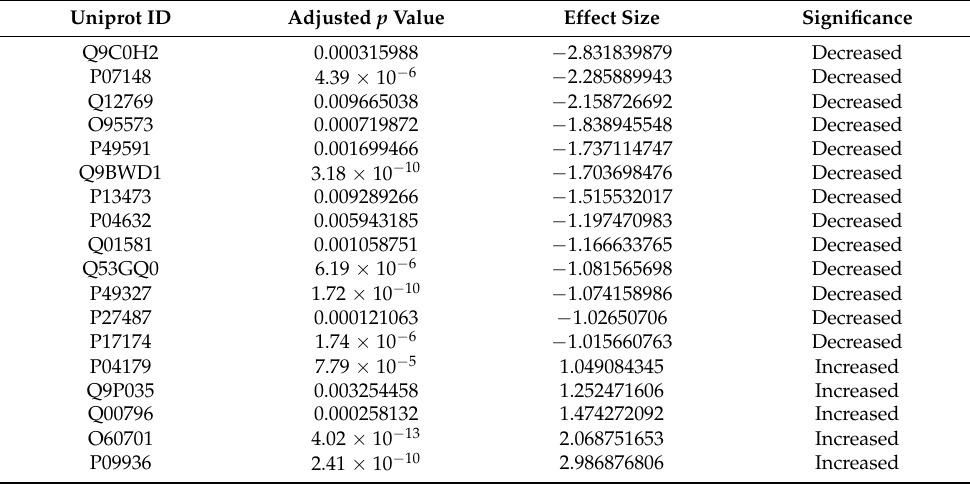
Figure 5. ( A ) Hierarchical cluster analysis and heatmap of differentially abundant proteins in resistant and parental phenotypes of Hep3B cells. Heatmap showing the abundance levels and clustering of the significantly differentially deregulated proteins (two-sample t -test with adjusted p value < 0.05; log2FC < 1; resistant/parental Hep3B cells). High protein intensities are colored red while low intensities are colored blue. Row headings represent protein names and column headings represent samples. Euclidean distance measure and Ward linkage analysis were used to carry out hierarchical clustering using the differentially abundant protein data. Heatmap analysis showed that the samples clustered into two separate groups, a group representing the resistant Hep3B cells and the other group representing the parental Hep3B cells. ( B ) Volcano plot showing those proteins which were altered significantly in resistant Hep3B cells vs. parental phenotype. Scatter plot showing the proteins log2-transformed fold-change (resistant/parental) plotted against the -log10( p value) highlighting the differentially proteins (two-sample t -test with BH FDR < 0.05). Down-regulated and up-regulated proteins are indicated in red and blue, respectively. Table 2. Gene ID refer to proteins significantly deregulated in resistant Hep3B cells in comparison to Parental Hep3B cells.